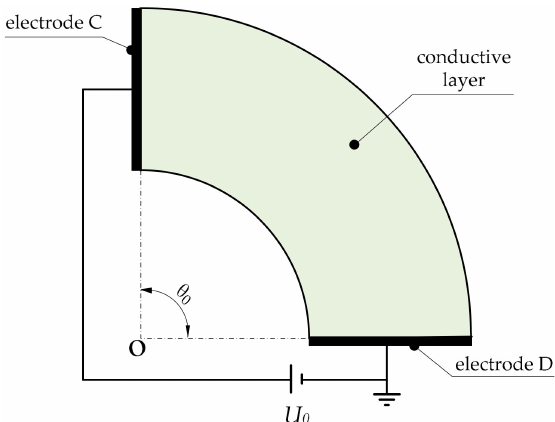
Figure 5. The setup for constructing an electric field to detect the coordinate of the polar